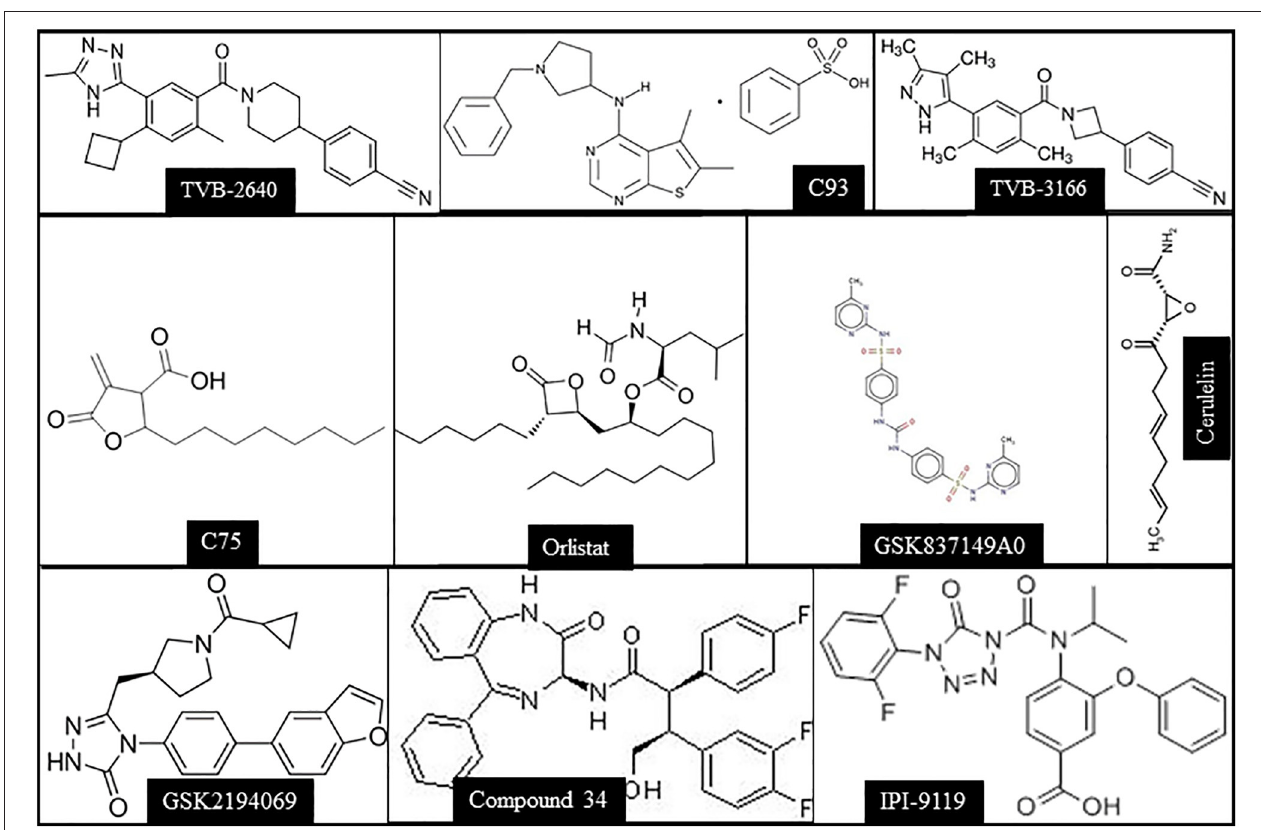
FIGURE 3 | Chemical structures of the main FASN inhibitors tested in preclinical and clinical